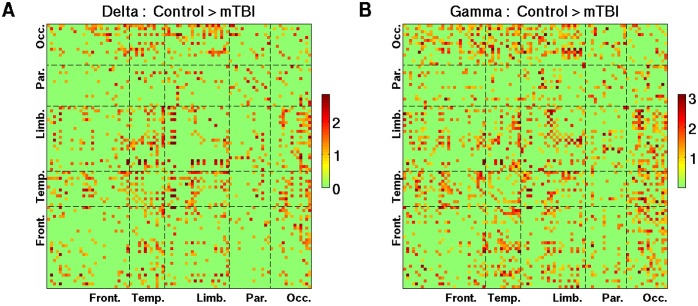
The 90 x 90 maps of the z-scores (bootstrap ratio values) reflecting higher phase synchrony in controls with respect to mTBI patients (see Fig 6C) in two canonical frequencies bands.(A) delta frequencies; and (B) gamma frequencies. Plotted are the connections associated with the bootstrap ratio values that are larger than 1.